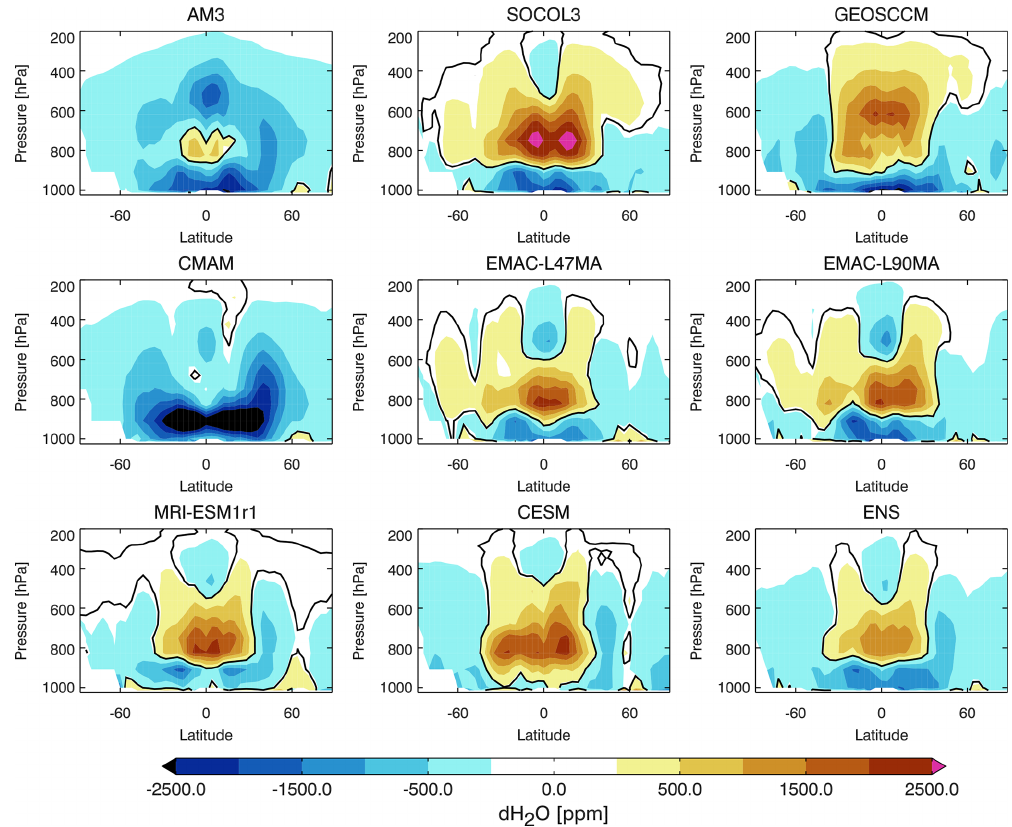
Figure 10. The zonal averaged vertical–latitudinal distribution of H 2 O biases (model to the ERAI reanalysis data). The black curves are the zero